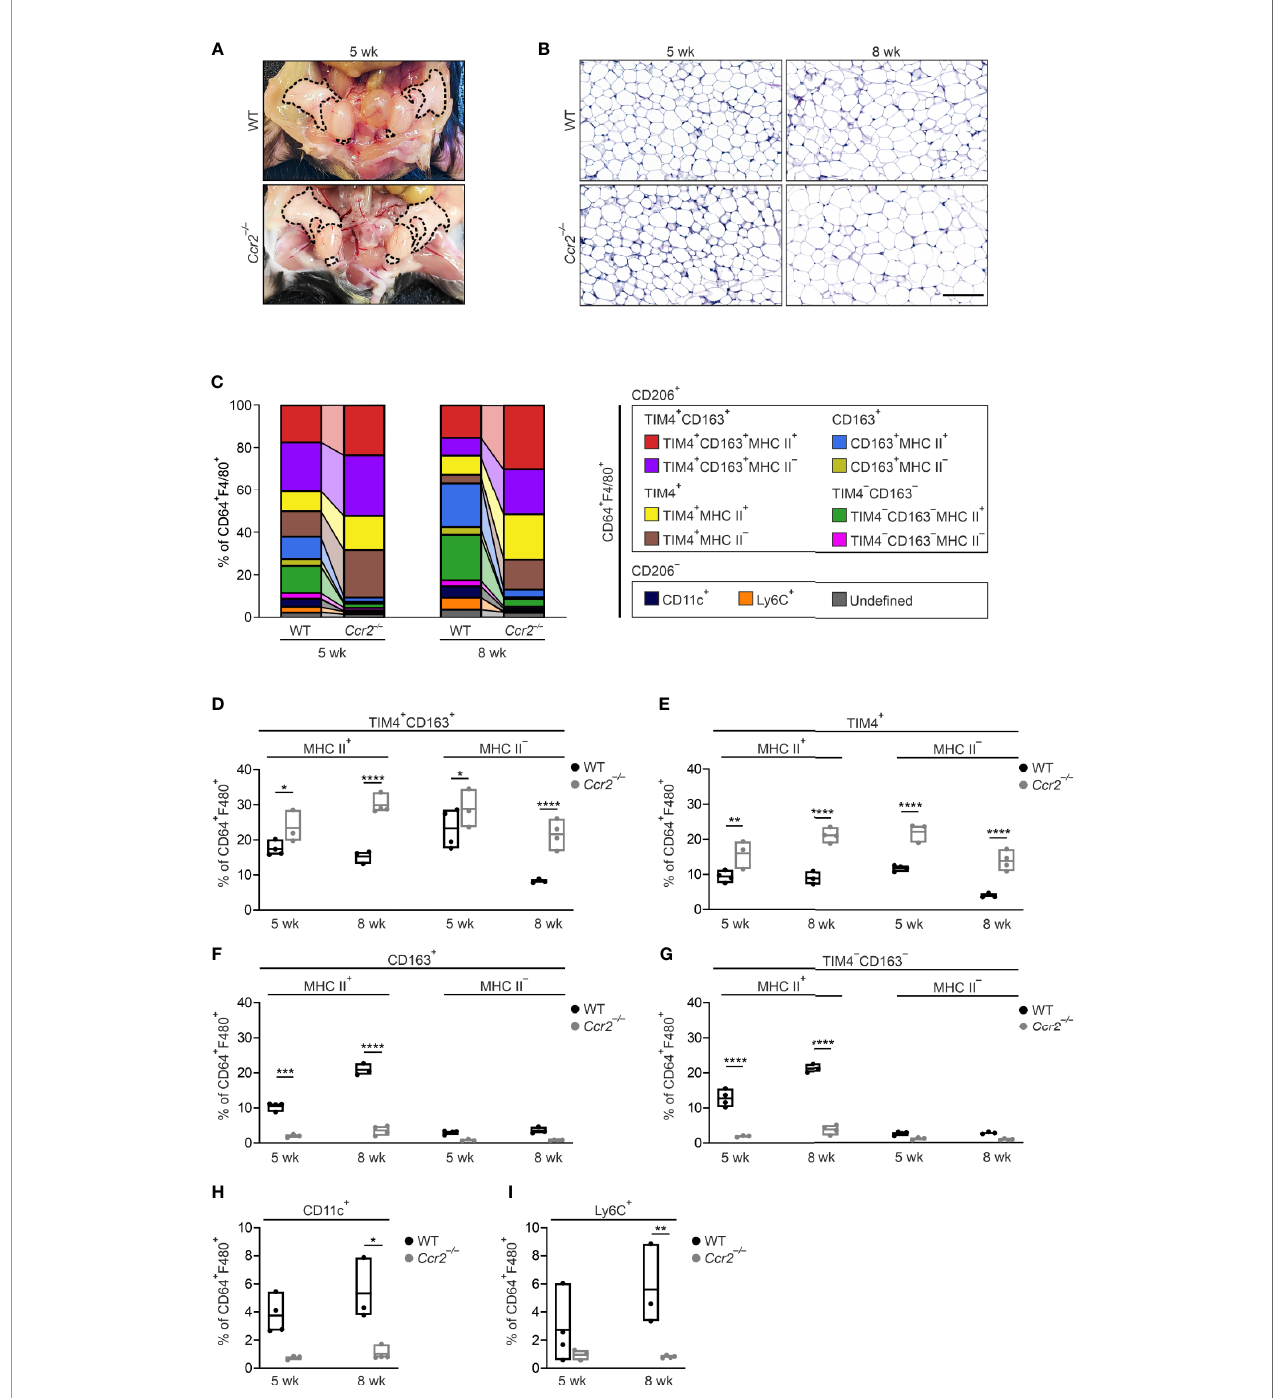
FIGURE 2 | CCR2-dependent traf fi cking of bone marrow-derived monocytes contributes differentially to eWAT macrophage subpopulations. (A) Representative macroscopic images of eWAT in 5-week-old wild type (WT) and Ccr2 -/- mice. Epididymal fat pads are outlined with a dashed line. (B) Representative PAS-stained histology of eWAT in 5- and 8-week-old WT and Ccr2 -/- mice. Scale bar 100 µm. (C) Frequencies of macrophage subpopulations in eWAT of 5- and 8-week-old WT and Ccr2 -/- mice based on the FlowSOM analyses at the indicated time points. Each FlowSOM metacluster (subpopulation) is represented by an individual color depicted in the columns. (D – I) Frequencies of eWAT macrophage subpopulations in Ccr2 -/- and WT mice. The quantitative data are shown as mean ± SEM (* P ≤ 0.0332, ** P ≤ 0.0021, *** P ≤ 0.0002, **** P ≤ 0.0001, two-way ANOVA with Bonferroni post-hoc test). Each data point represents a pooled eWAT from 3 mice for 5 wk and 2 mice for 8 wk. All mass cytometry data are from 2 (8 wk WT) or 3 (5 wk WT, and 5 and 8 wk Ccr2 -/- ) independent